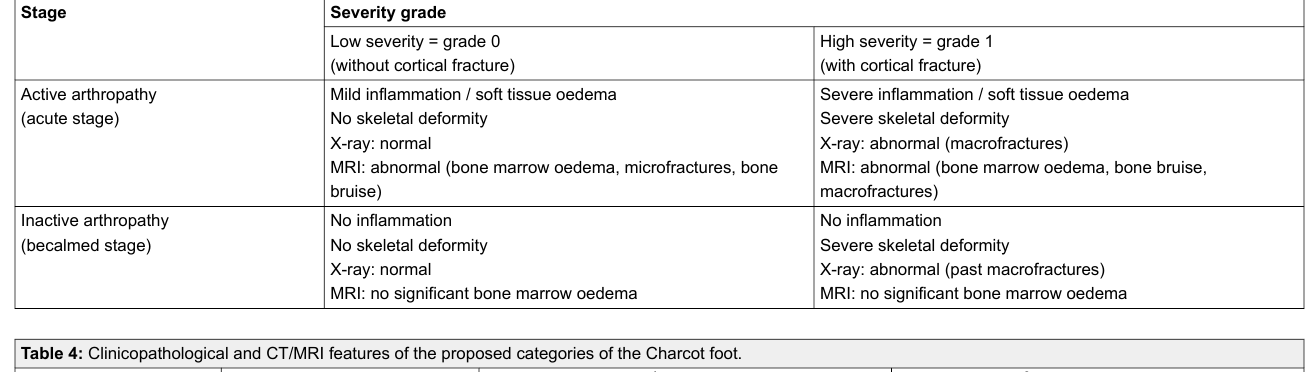
Table 4: Clinicopathological and CT/MRI features of the proposed categories of the Charcot foot. Clinical